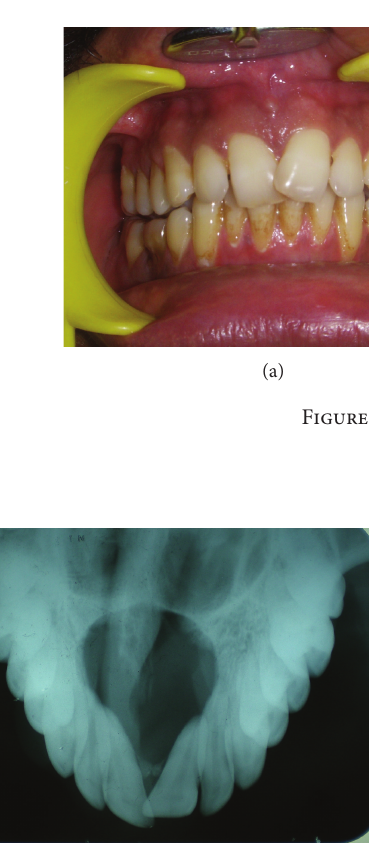
Figure 2: Maxillary occlusal view showing well defined radiolu- cency in the anterior maxilla.